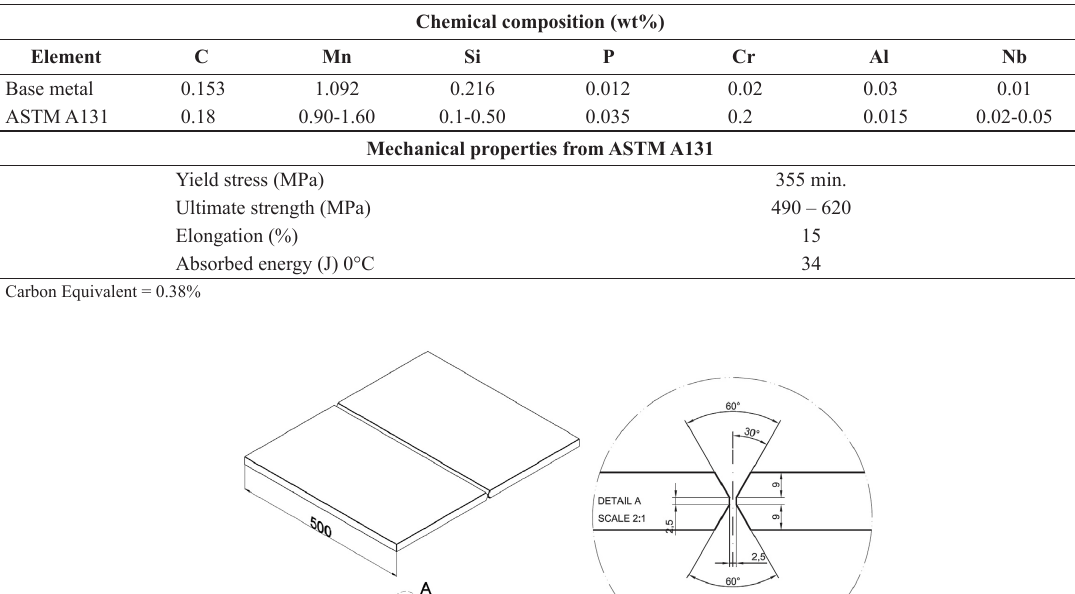
Table 1: Chemical composition and mechanical properties of the base metal.